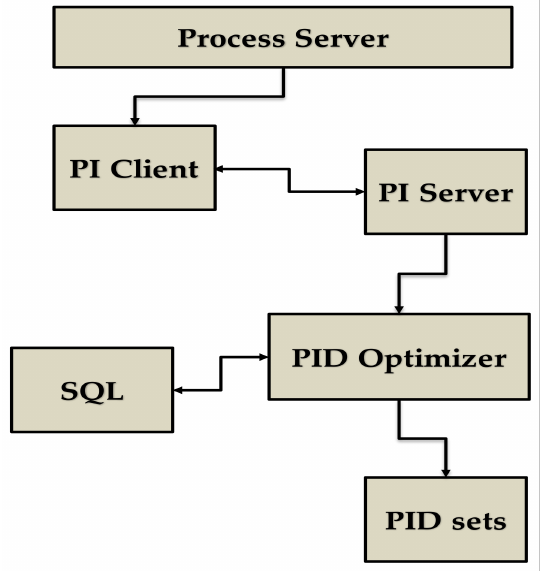
Figure 2. Data extraction and